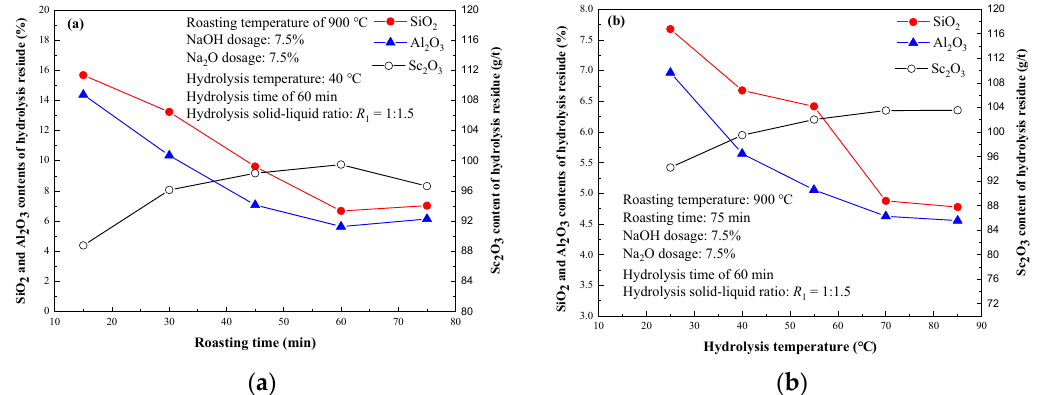
Figure 4. Effect results of alkali fusion roasting time ( a ) and hydrolysis temperature ( b ). Figure 4. E ff ect results of alkali fusion roasting time ( a ) and hydrolysis temperature ( b